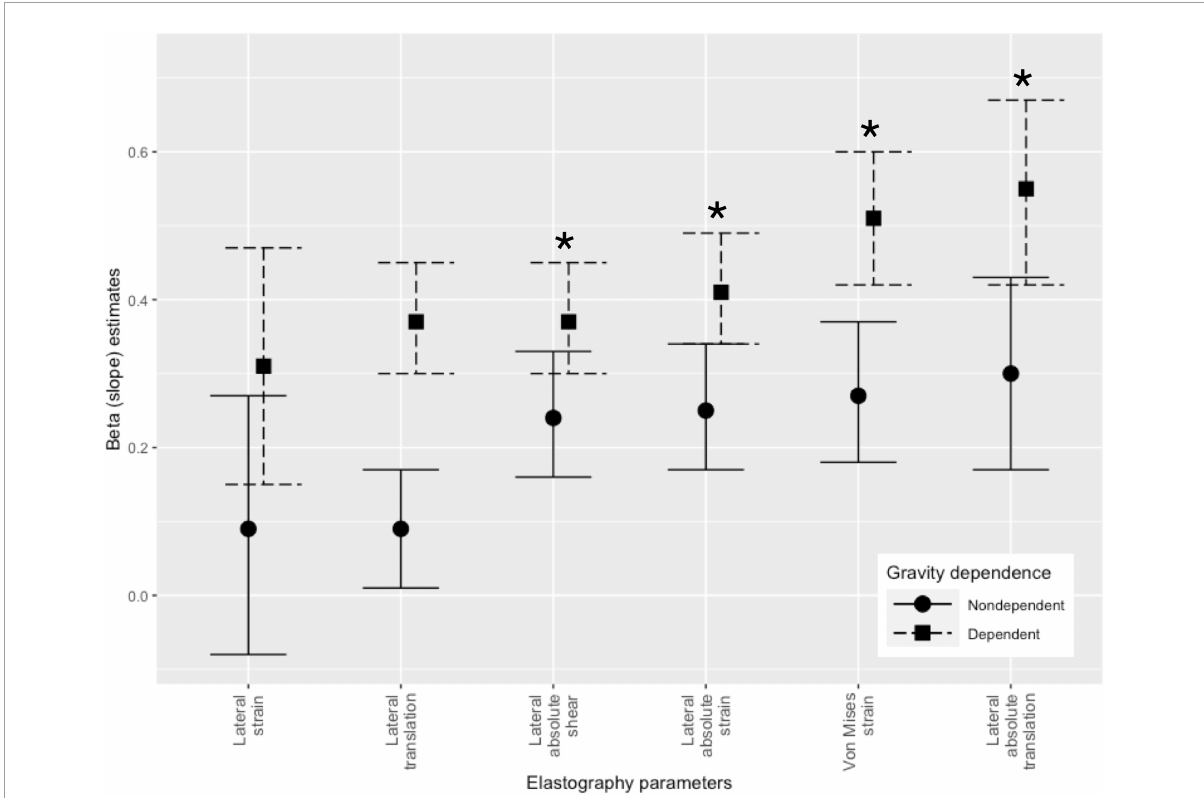
FIGURE3 Slope estimates for elastography parameters in increasing order stratified by gravity dependence. Significant parameters are identified by an